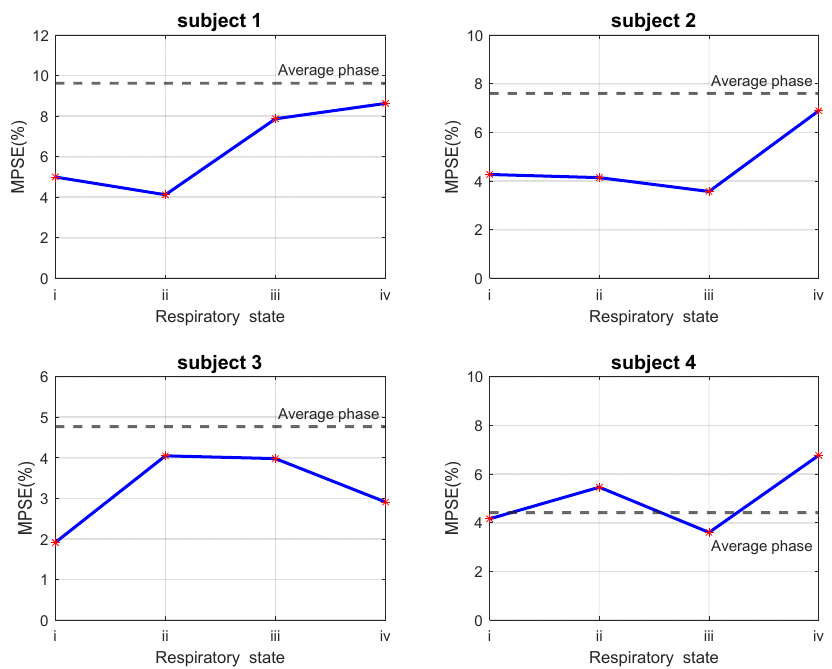
Figure 8. Phase-resolved lung images and corresponding PSE map of subject 1. The first column represents image without phase segmentation, where blur on diaphragm was highlighted by red dash square. The corresponding phase-resolved images are listed in columns 2 to 5 from end-expiratory to end-inspiratory. The tissues’ signal highlighted by red arrows in oxygen image are stronger than that in air image. The bottom row is PSE map fused on the same coronal plane with a specific PSE value of 9.63%, 5.0%, 4.12%, 7.87%, and 8.63%. Figure 9 shows the mean PSE of each segmented phase of all four subjects from end- expiration to end-inspiration. The MPSE of end-inspiration state (state iv) is higher than the value at the end of expiration (state i), statistically increasing 72.6%, 61.4%, 52.4%, and